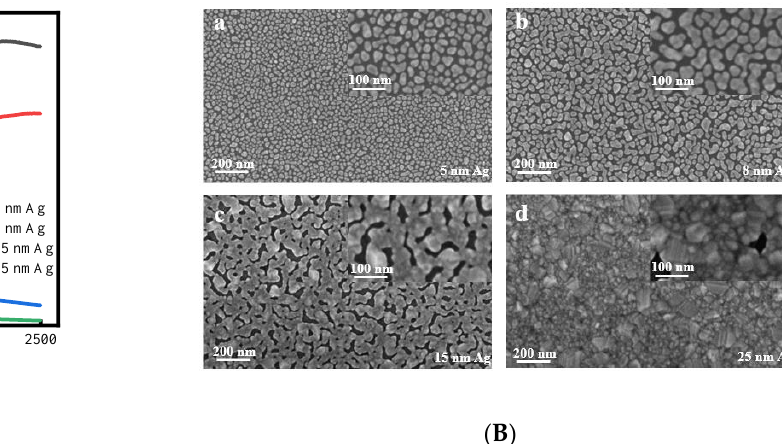
Figure 3. ( A ) Curves of transmittance of silver films with different thickness varying with wavelength. ( B ) SEM images of silver films with different thickness on a K9 substrate ( a – d ).